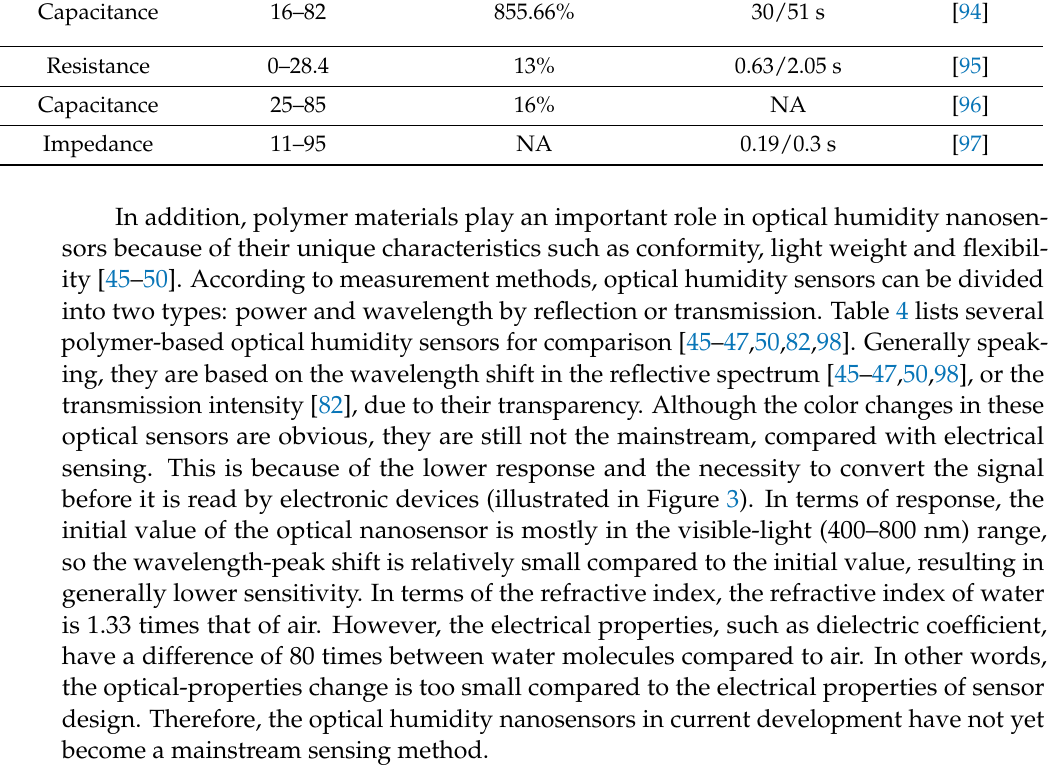
Table 4. The polymer-based optical humidity sensors